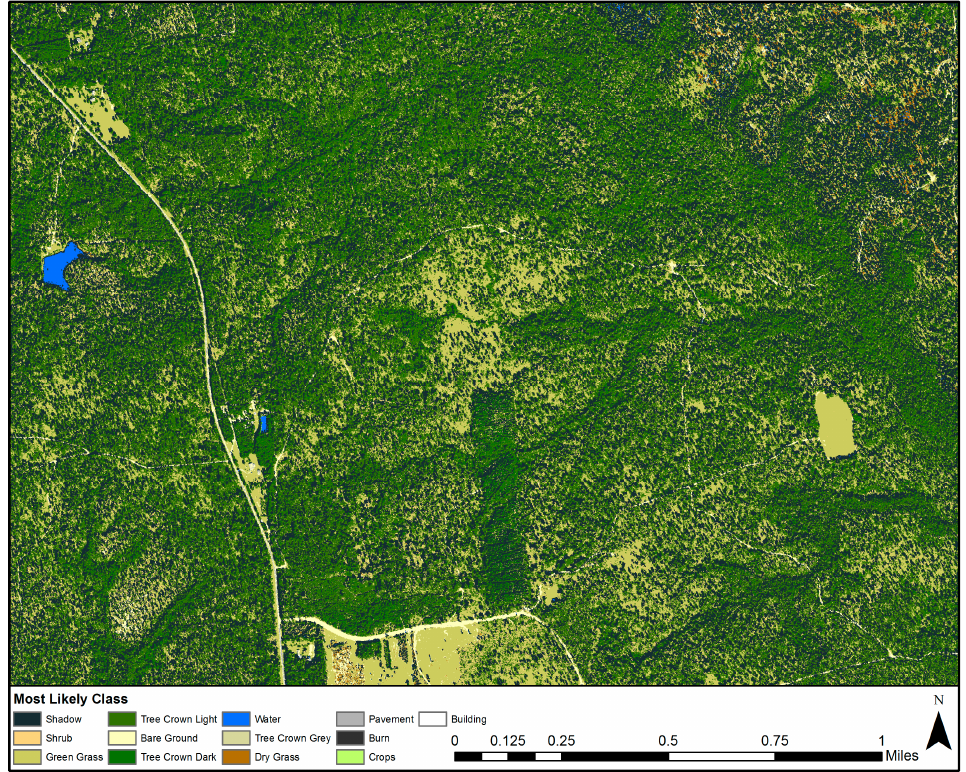
Figure 6. Example of a high-resolution land classification generated by applying a most likely class (MLC) rule to a 13 band probabilistic land cover classification.